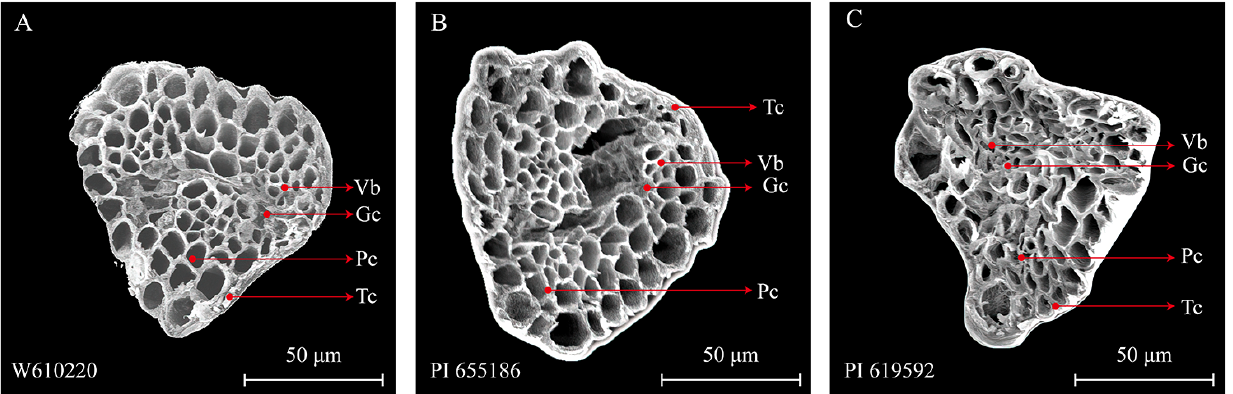
Figure 6. Anatomical structure image of three accessions at heading stage: ( A ) long awn; ( B ) medium awn; ( C ) short awn; Gc: green cells; Pc: parenchymal cells; Tc: thick walled cells; Vb: vascular bundle.